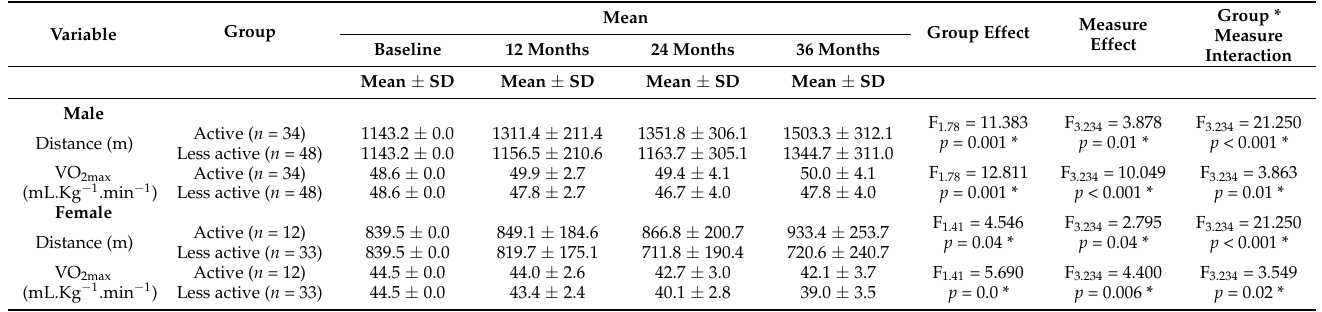
Figure 1. Mean and standard deviation of the physical activity score in males and females over the years of study. Table 2. Association between aerobic fitness and level of physical activity according to sex over the 36-month study